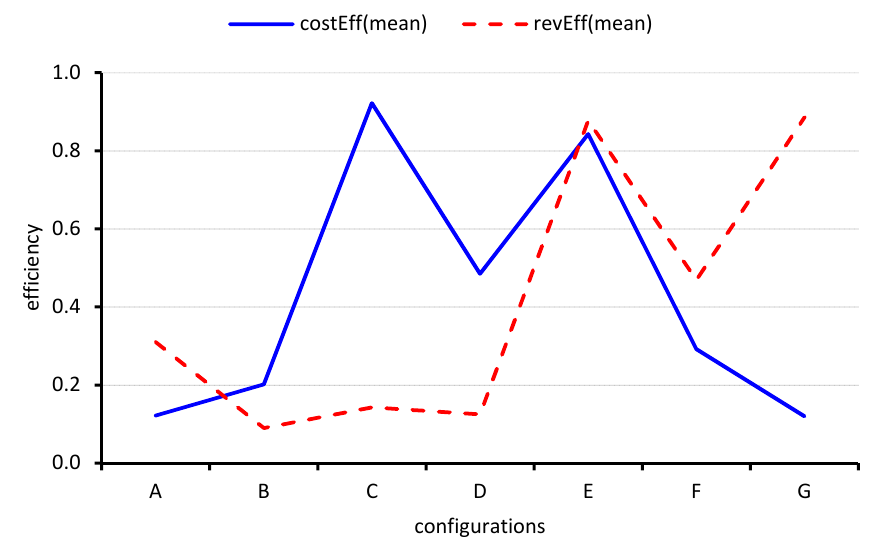
Figure 4. Plot of costEff and revEff centroids (means) relatively to the seven configurations. Table 6. Statistics of DEA model variables relative to sample configurations.